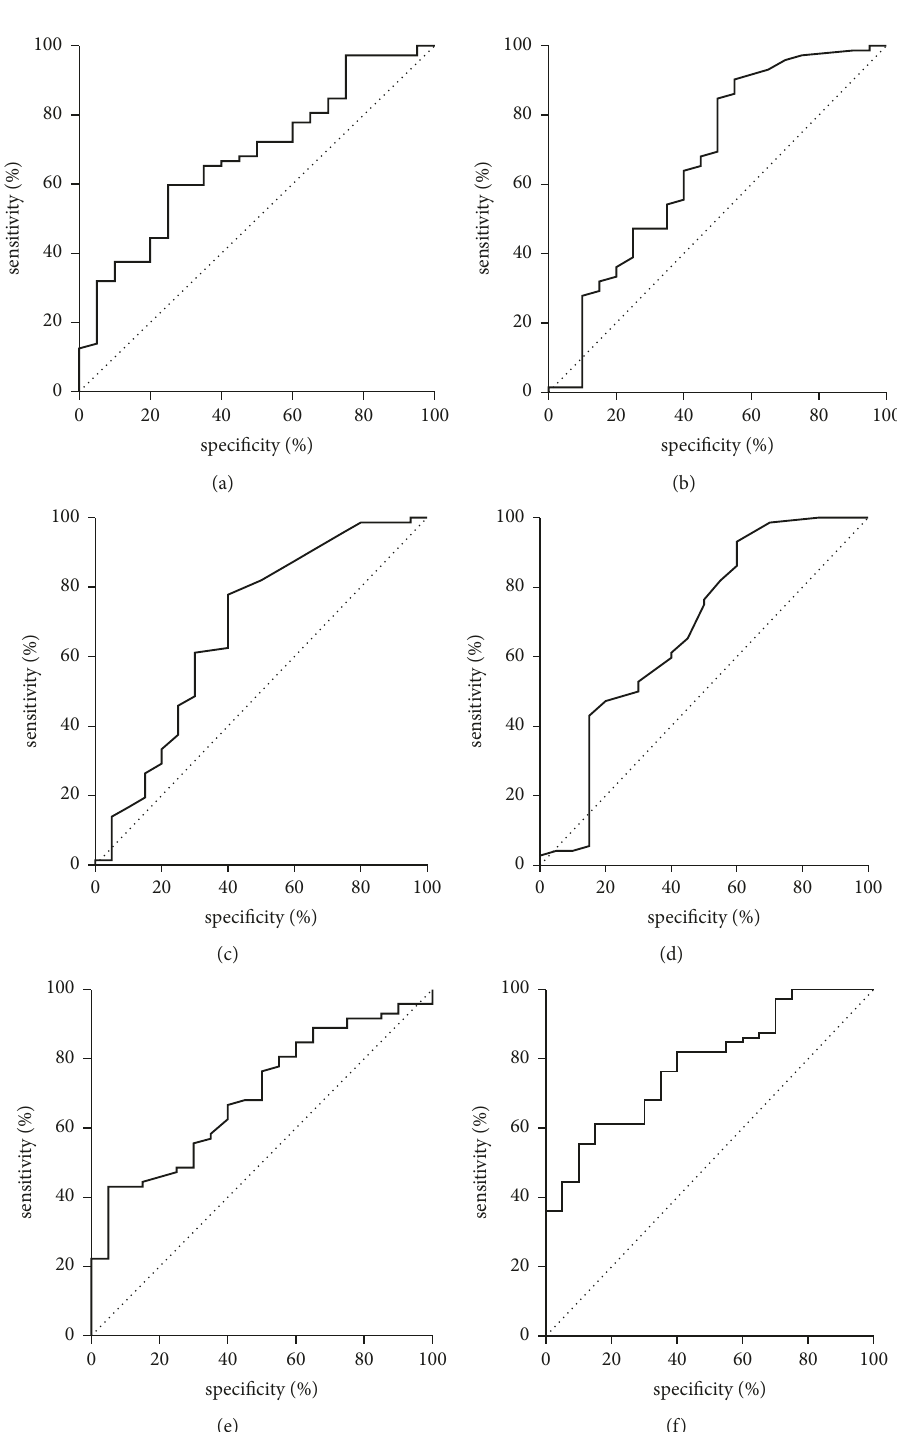
Figure 2: ROC curve for ability of IL-18 (a), ALT (b), AST (c), GGT (d), TG (e), and their combination (f) to detect children with liver steatosis in 1